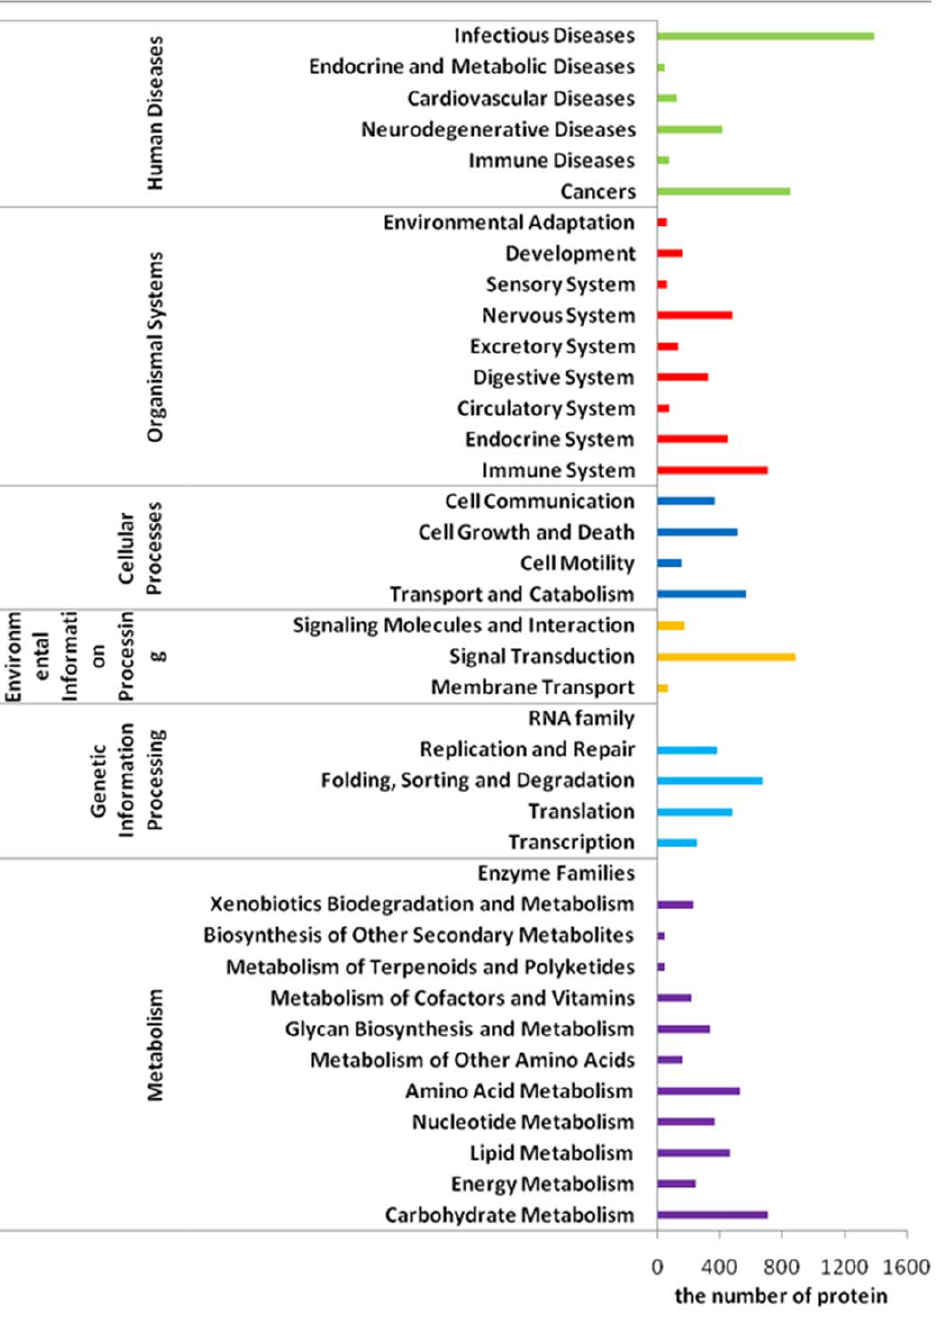
Figure 3. Distributions of the KEGG pathways. Putative proteins were mapped the reference canonical pathways in the KEGG database. The bar chart shows the number of sequences among different pathway categories: Out of 45,771 putative proteins, 5135 sequences were assigned to the KEGG pathways among six categories.